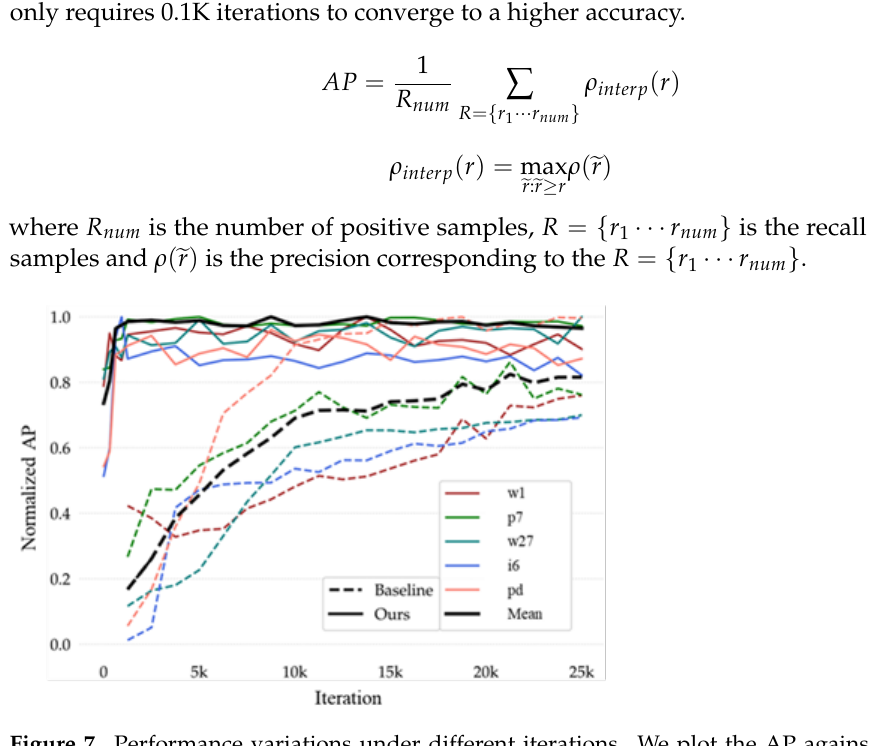
Figure 7. Performance variations under different iterations. We plot the AP against number of training iterations that reflect the adaptation speed of algorithm. Meta-YOLO manifests much faster adaption speed.